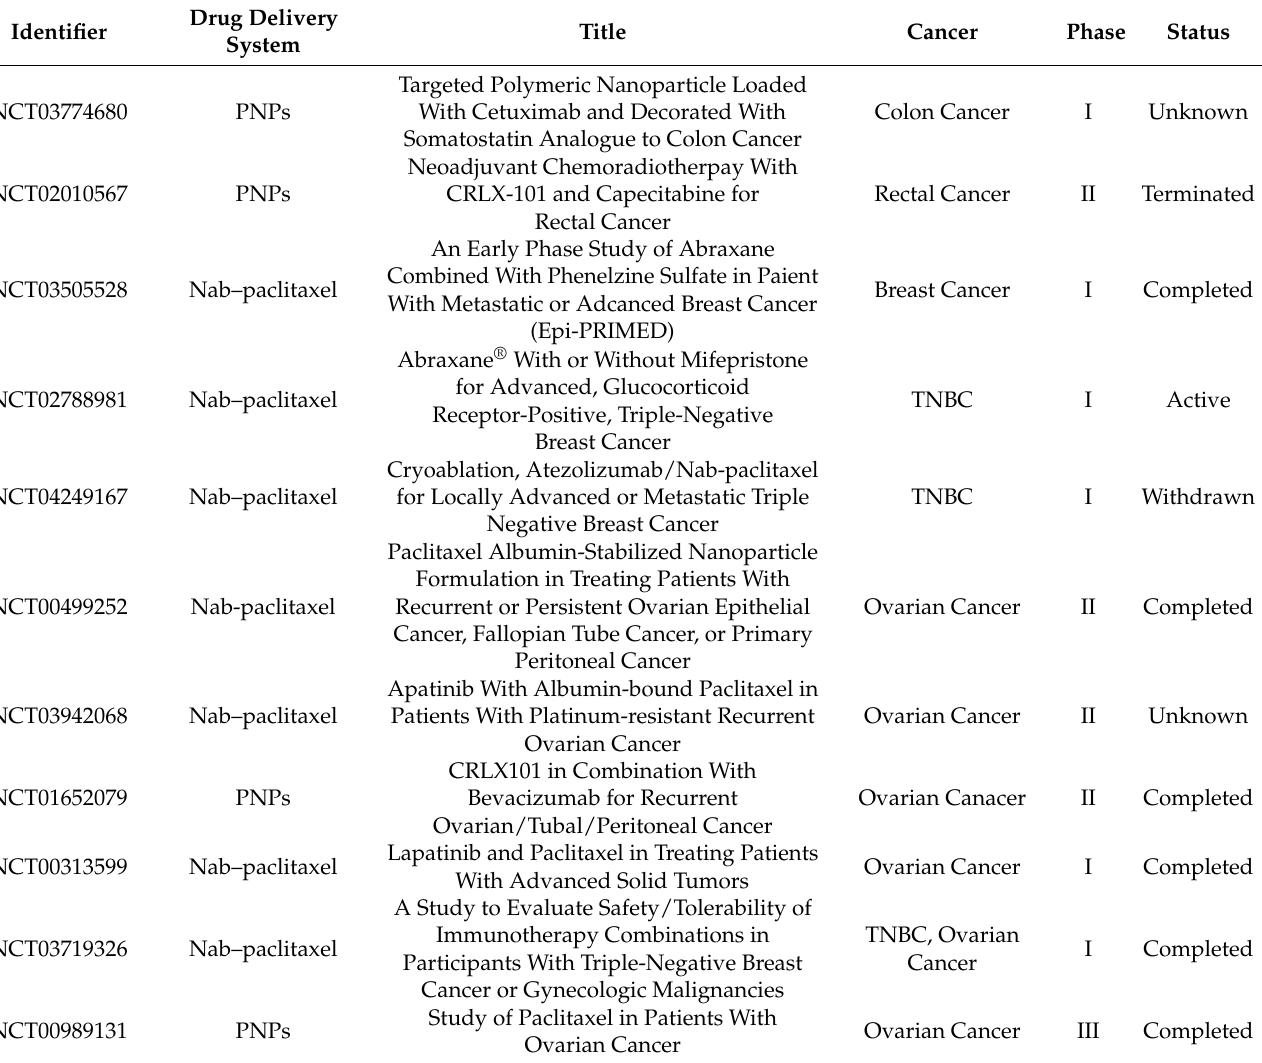
Table 5. Clinical trials using PNPs in selected cancer therapy based on https://clinicaltrials.gov/ (accessed on 10 September